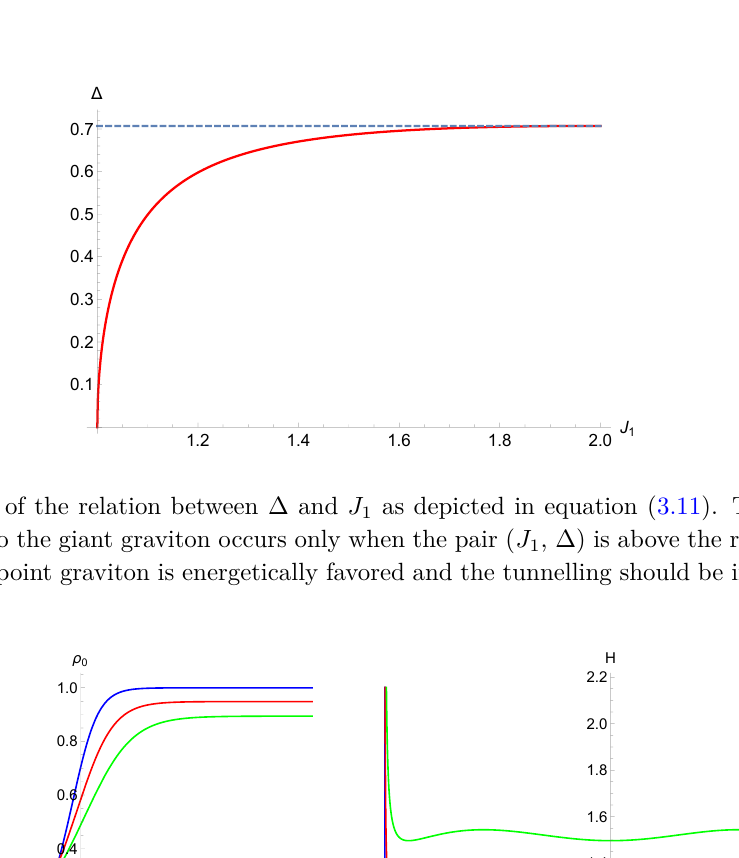
. Right plot: Hamiltonian for the 1 is: Blue ⇒ J = 1 . 01 , 1 1